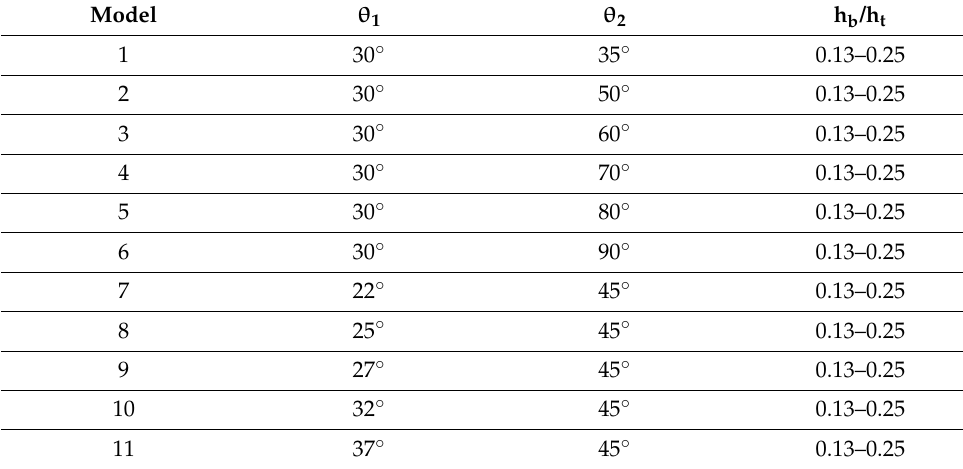
Table 2. Models are based on the variation in bypass